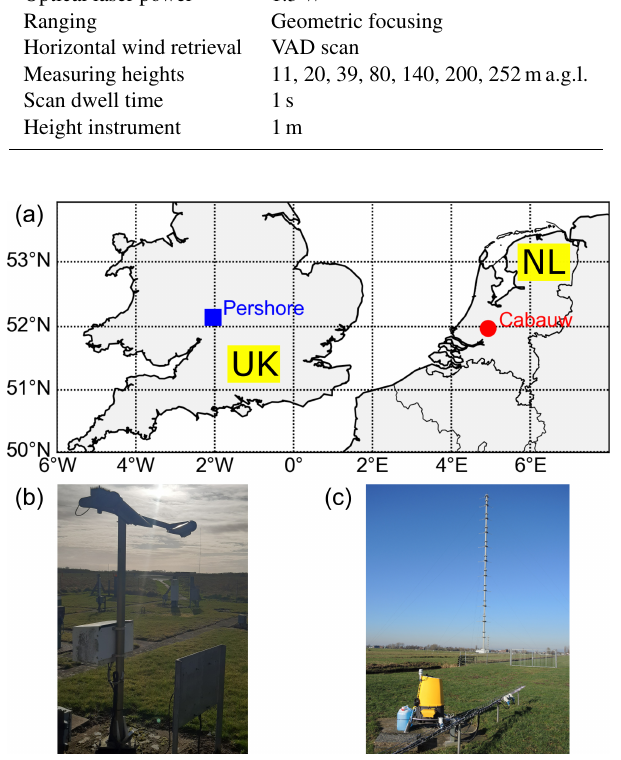
Figure 2. Location of lidar and visibility sensors